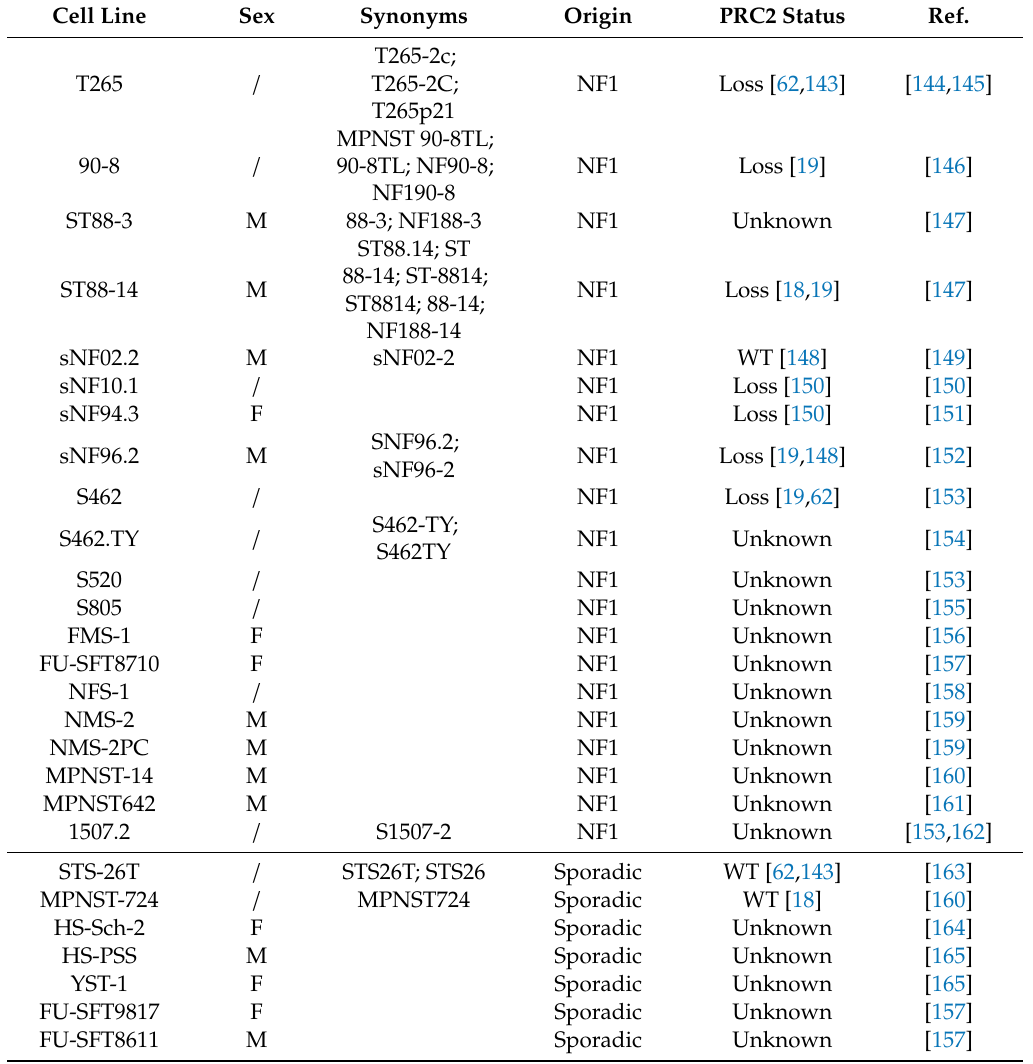
Table 1. A summary of immortalized cell lines used in MPNST